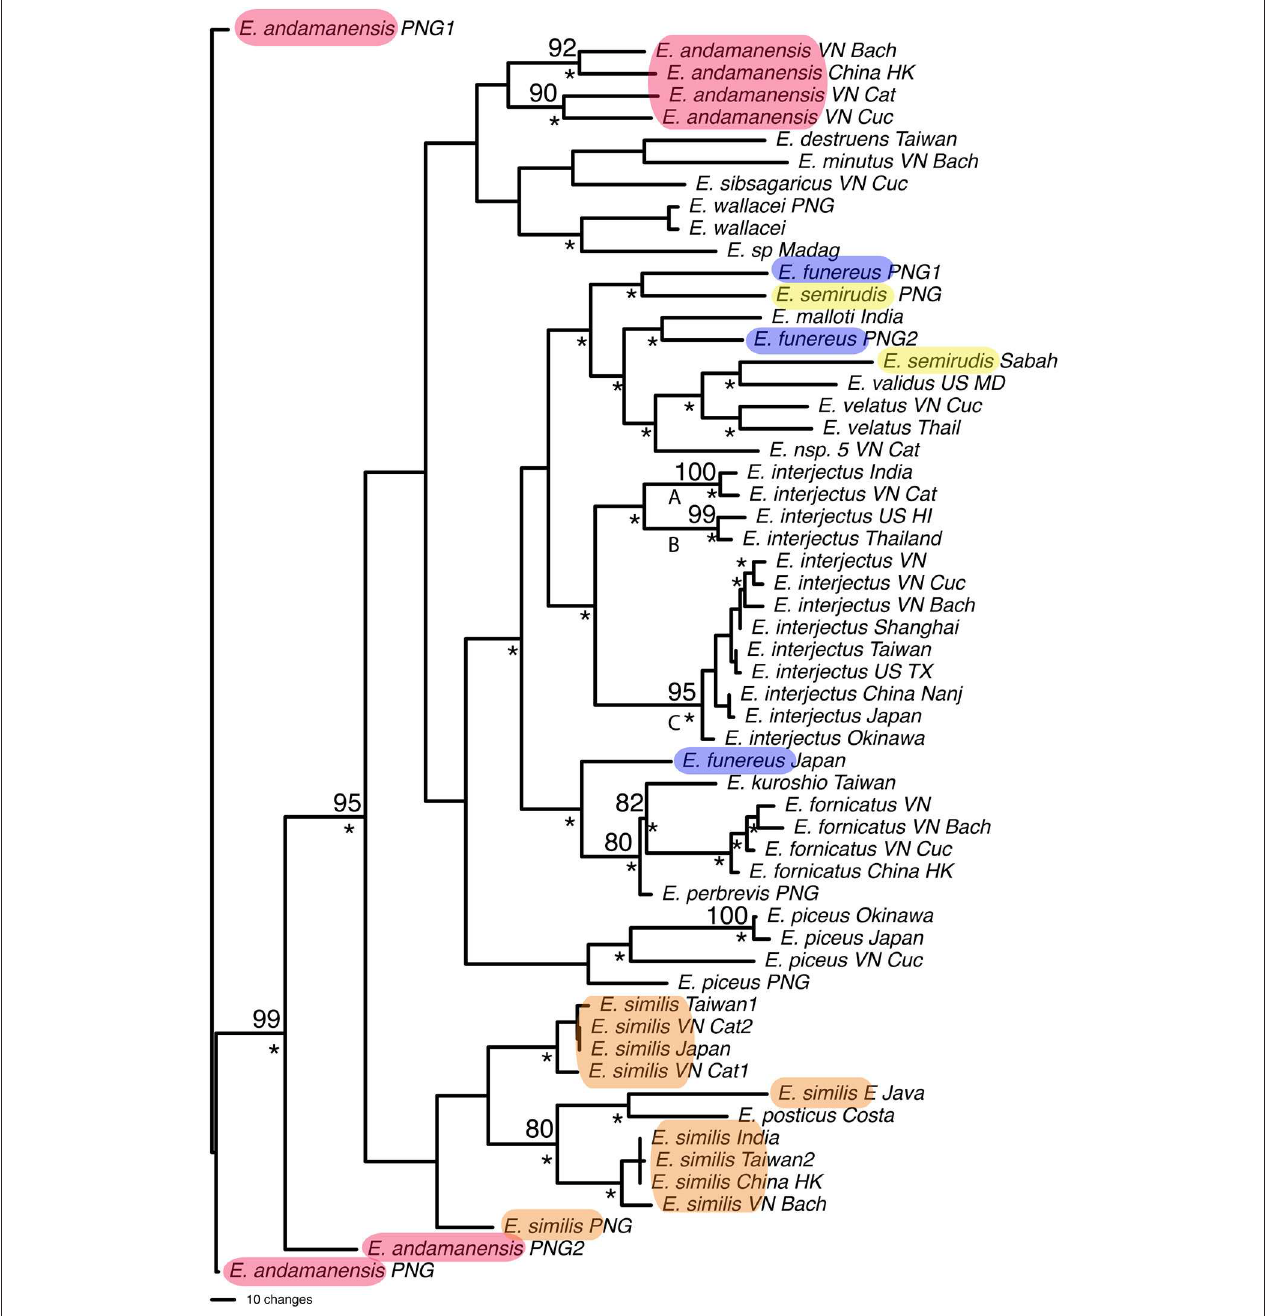
FIGURE 5 | One of 2,475 most parsimonious trees found for Euwallacea species based on COI and CAD data. Numbers indicate bootstrap values. *Clade found in the strict consensus of most parsimonious trees. Highlighted species are not monophyletic.